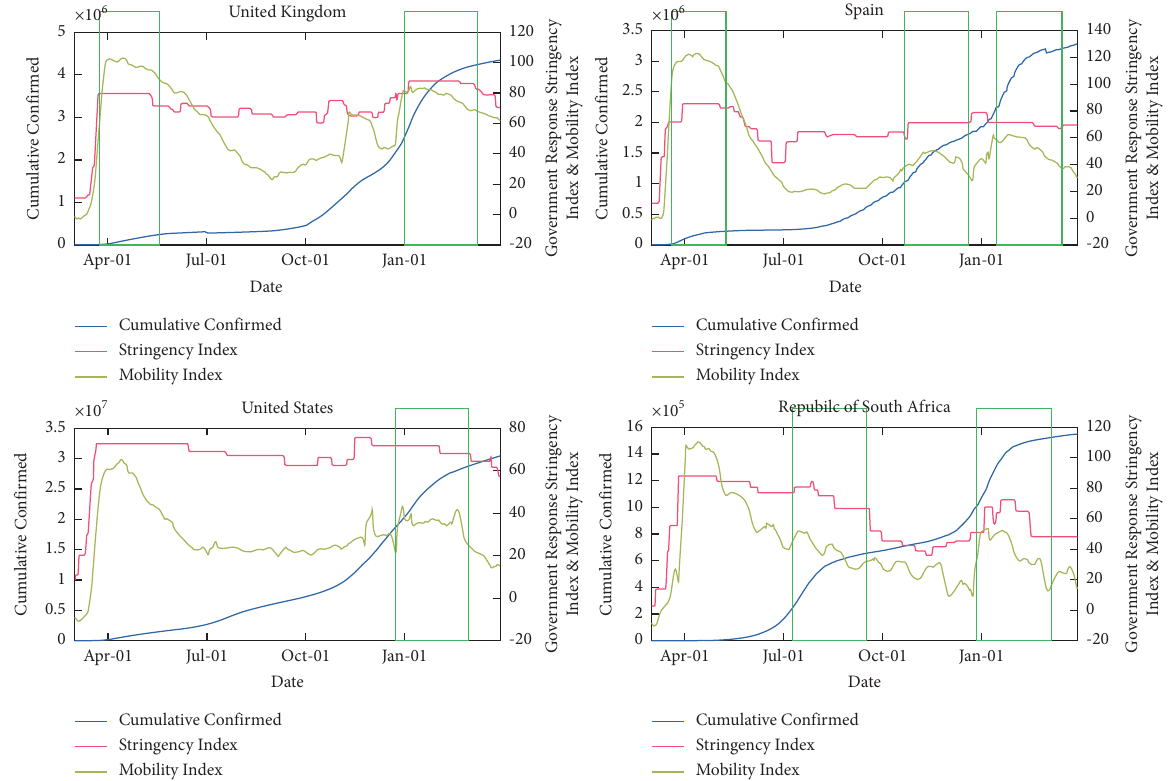
Figure 7: Cumulative confirmed cases, stringency index, and mobility index in the United Kingdom, Spain, the United States, and the